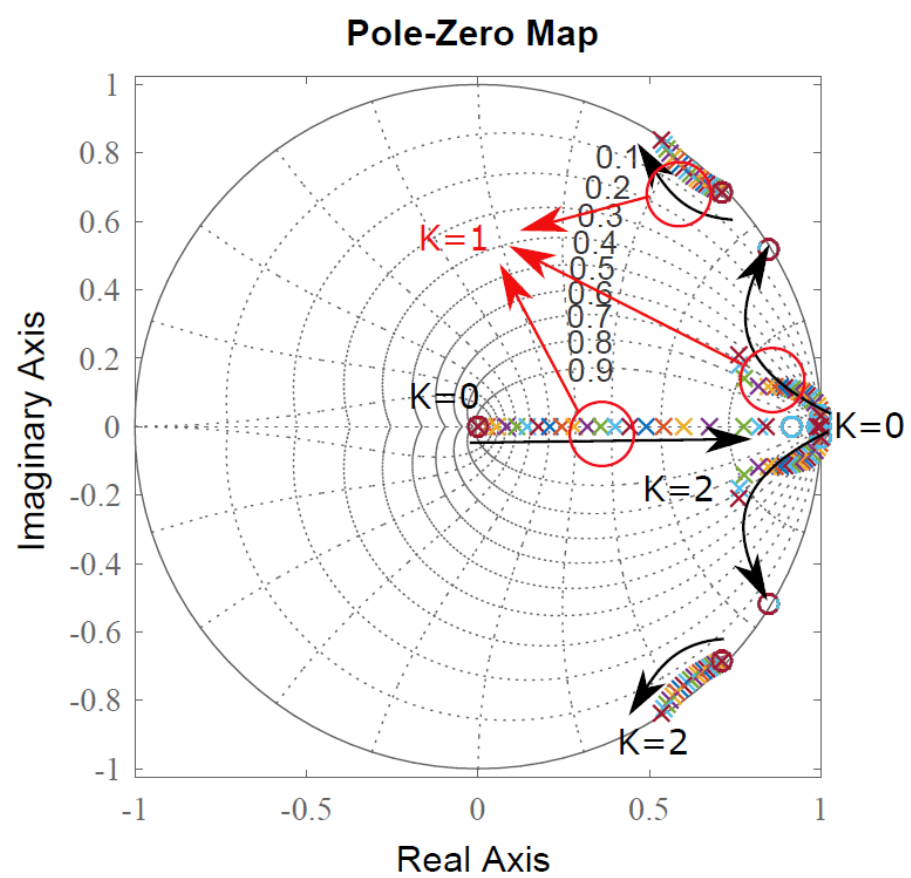
Figure 6. VSC Z-domain pole zero map of the inner current control